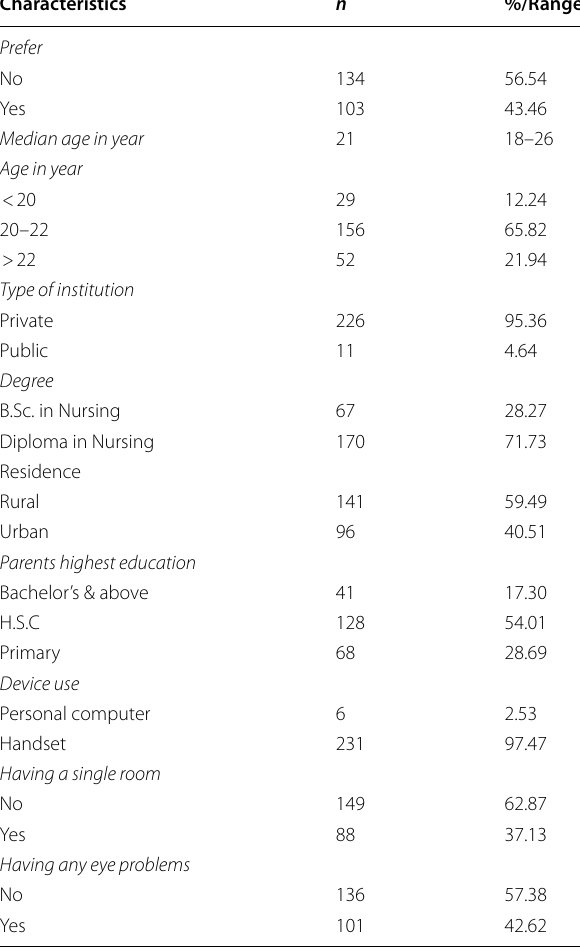
Table 1 Baseline characteristics of the study